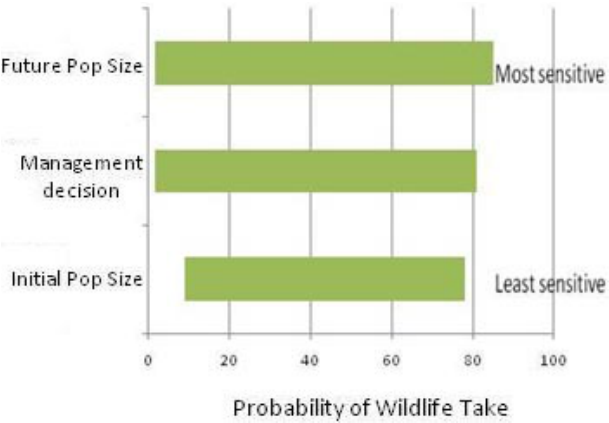
Fig. 4. Tornado diagram of one-way sensitivity analysis for the Wildlife Take node. The probability of Wildlife Take is most influenced or sensitive to Future Population Size. The bar lengths represent the extent to which the probability of Wildlife Take varies in response to changes in the value of that model component.. Fig. 5. Tornado diagram of one-way sensitivity analysis for the management